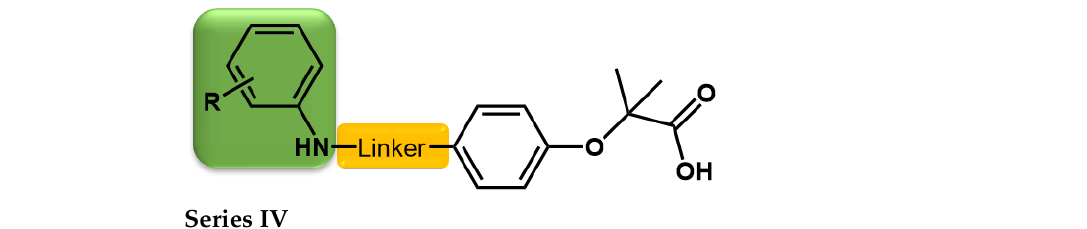
10 of 36 Series III Table 3. Results of in vitro red blood cell studies. Compound